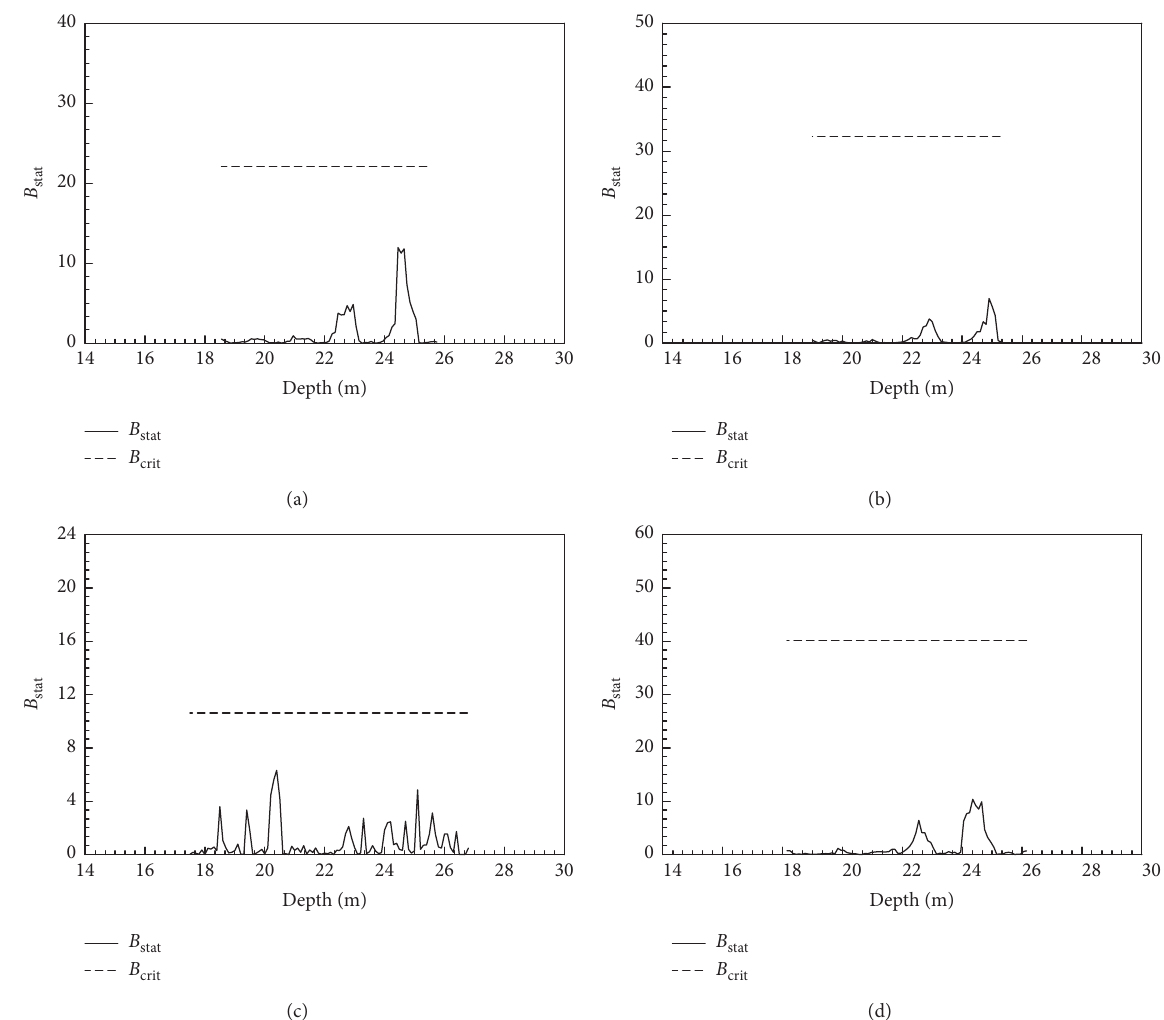
Figure 7: Validation of stationarity of CPT data for the medium clay layer. (a) M